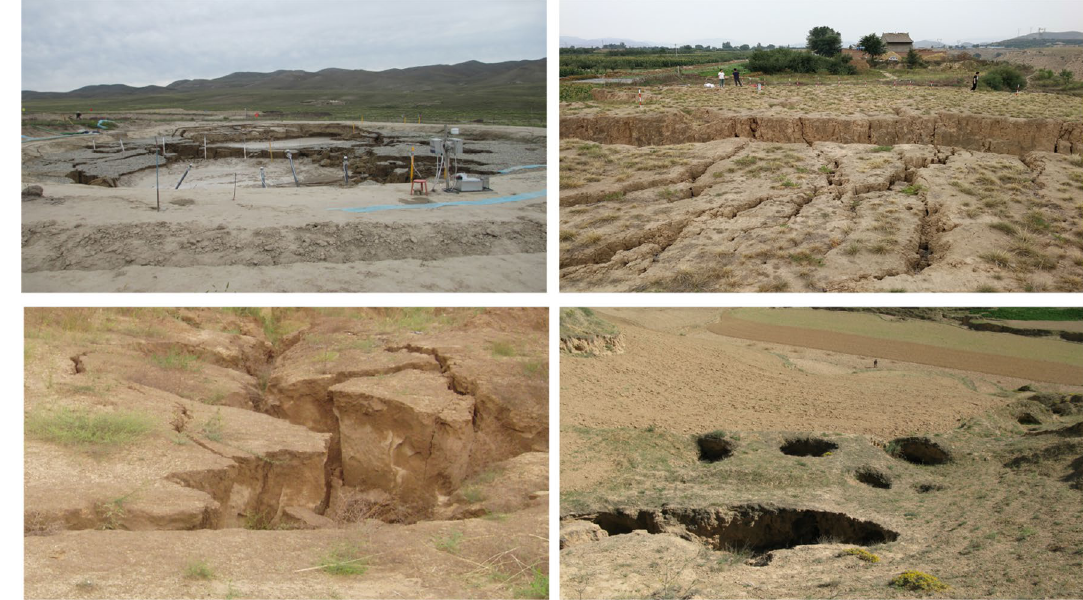
Figure 1. Demonstration of typical hazards caused by Loess